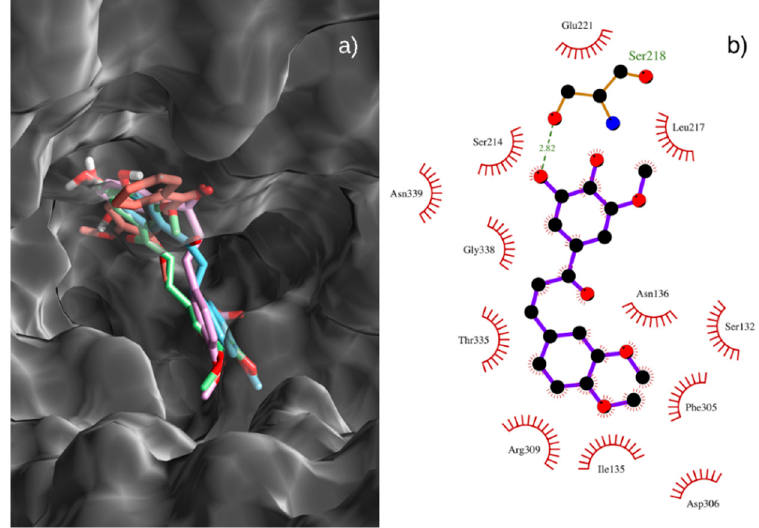
Figure 3. ( a ) Best poses of chalcones 1 (tinted blue), 3 (pink), 4 (green) and 5 (orange) on the binding site of the NorA model. ( b ) 2D ligand-protein interaction diagram of chalcone 4 and the NorA protein model. Contacts depicted in green.